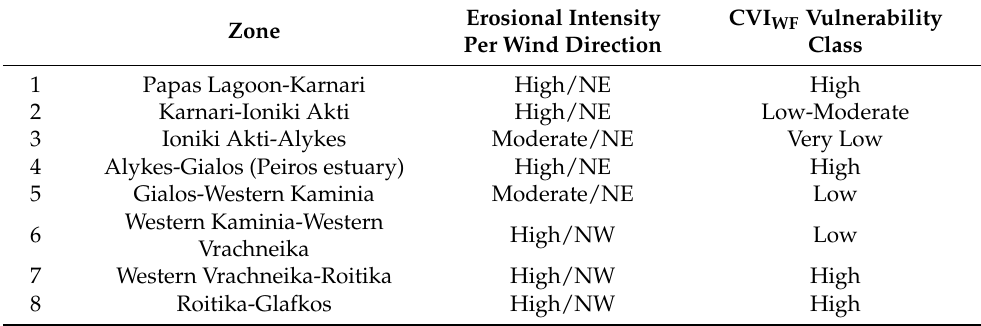
Table 3. Results of the CVI WF compared with erosional intensity per wind direction.